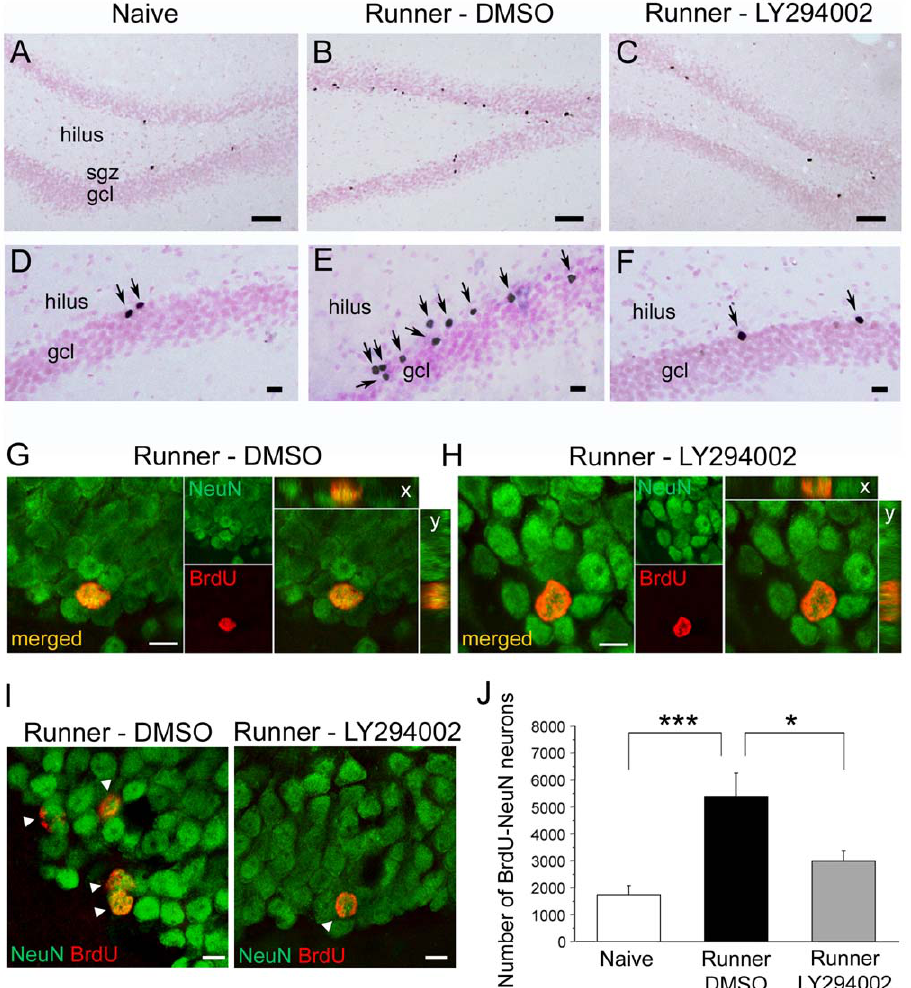
Figure 5. Effect of running and inhibition of the PI3K-Akt signalling pathway on dentate gryus neurogenesis. A–C, Representative light photomicrographs of Nuclear fast Red-stained sections shows distribution of BrdU immunoreactive nuclei in the dentate gyrus of (A) naı¨ve, (B) DMSO-treated and (C) LY294002-treated runners (sgz, subgranular zone; gcl, granule cell layer). D–F, Higher magnification illustrates increased numbers of newborn cells in the gcl (arrows) in (E) DMSO-treated runners compared to (D) naı¨ve rats and the reduction in the number of BrdU- labeled cells in (F) LY294002-treated runners. G,H, Confocal image of double-stained cells for BrdU (red) and NeuN (green) illustrates co-localisation in dentate granule cells (arrowheads) in representative sections from animals in the DMSO-treated (G) and LY294002-treated (H) runners. I, Representative confocal laser scanning microscope stack images depict cells double-labeled (merged) for BrdU (red) and NeuN (green) in the dentate gyrus in animals from both groups. BrdU-NeuN double-labeled cells are shown in x–y orthogonal planes and z-sectioning at 0.5 m m intervals (right) to confirm overlap of the two immunoreactions. J, Quantitative data 14–16 days after BrdU injections are expressed as the total number of BrdU-labeled cells (all groups, n=5). Scale bars 100 m m (A–C), 25 m m (D–F) and 10 m m